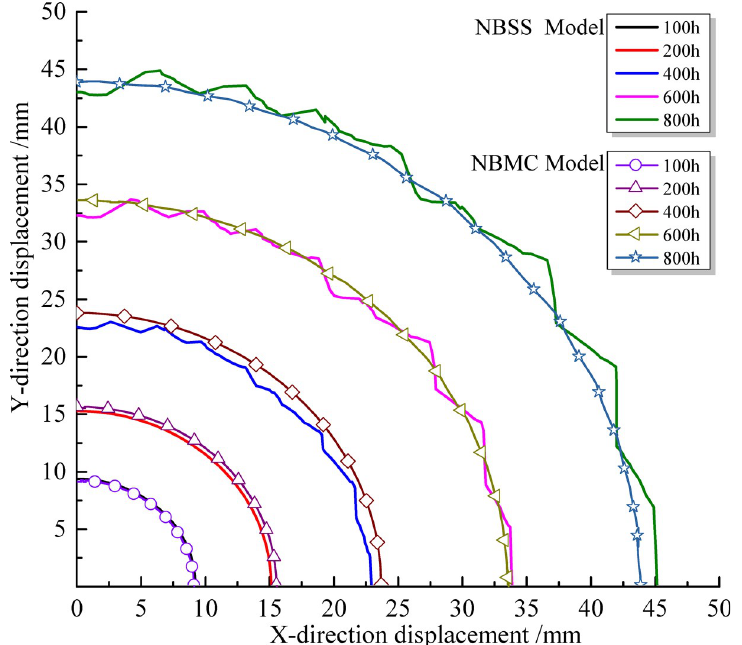
Fig 16. Deformation of rock surrounding a tunnel over